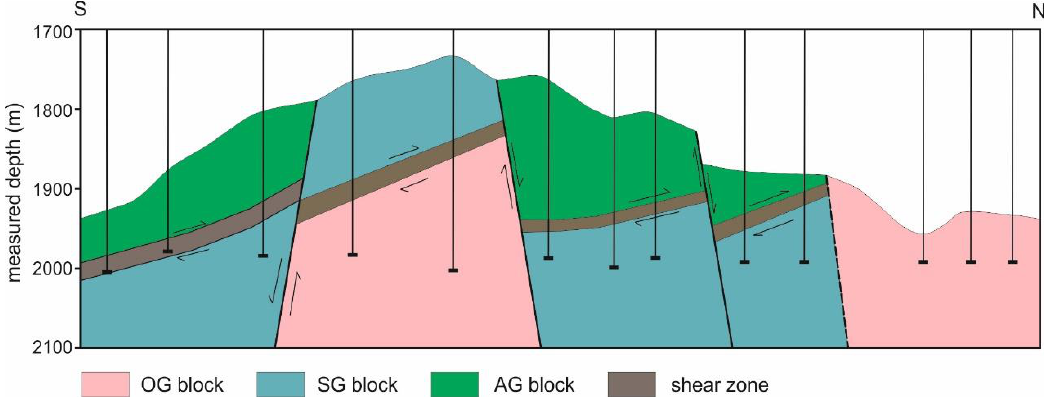
Figure 2. N–S geological section across the highest point of the Szeghalom metamorphic dome (modified from [19]) .